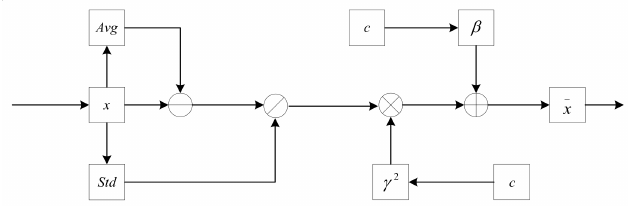
Figure 4. Structure of CLN